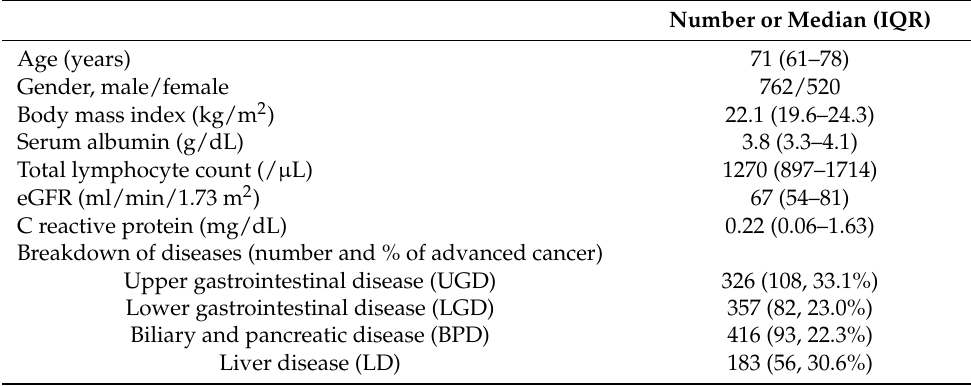
Table 1. Baseline characteristics ( n =